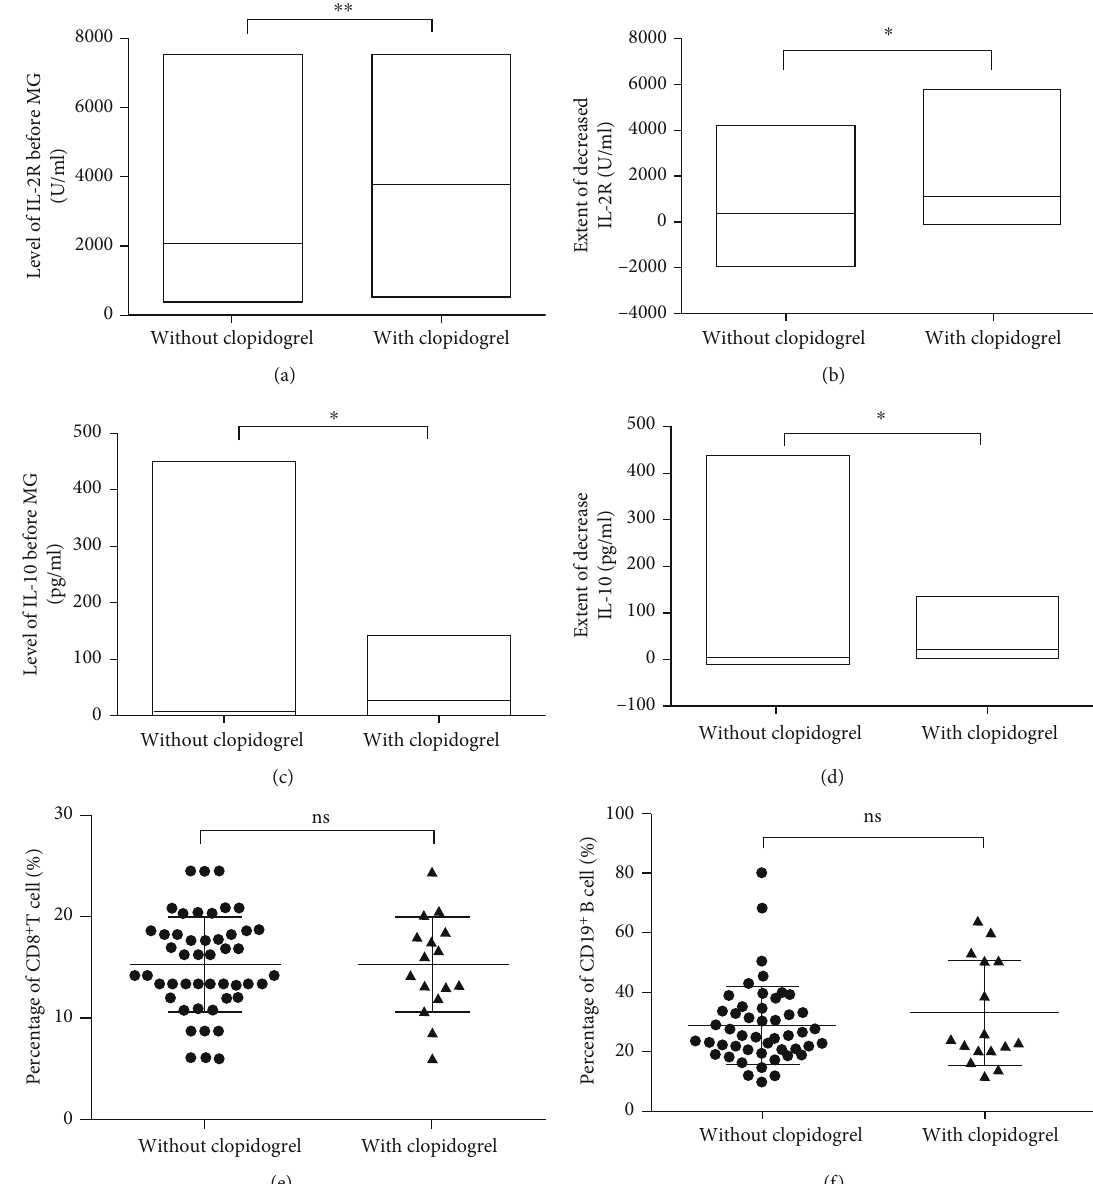
Figure 5: Levels of IL-2R and IL-10 in children with KD treated with or without clopidogrel. (a) The levels of IL-2R before IVIG in patients treated with clopidogrel were higher than those in patients who were treated without clopidogrel. ∗∗ P < 0 : 01 . (b) The extent of the decrease of IL-2R was signi fi cantly higher in children with KD treated with clopidogrel than that in those treated without clopidogrel. ∗ P < 0 : 05 . (c) The levels of IL-10 before IVIG in patients treated with clopidogrel were higher than those in patients who were treated without clopidogrel. ∗ P < 0 : 05 . (d) The extent of the decrease of IL-10 was signi fi cantly higher in children with KD treated with clopidogrel than that in those treated without clopidogrel. ∗ P < 0 : 05 . (e) There was no di ff erence in the percentage of CD8 + T cells between the children with KD treated with and without clopidogrel, and the means and standard deviations were, respectively, 15 : 43 ± 0 : 68 and 15 : 43 ± 1 : 20 . (f) There was no di ff erence in the percentage of CD19 + B cells between the children with KD treated with and without clopidogrel, and the means and standard deviations were, respectively, 28 : 98 ± 1 : 92 and 32 : 96 ± 4 : 44